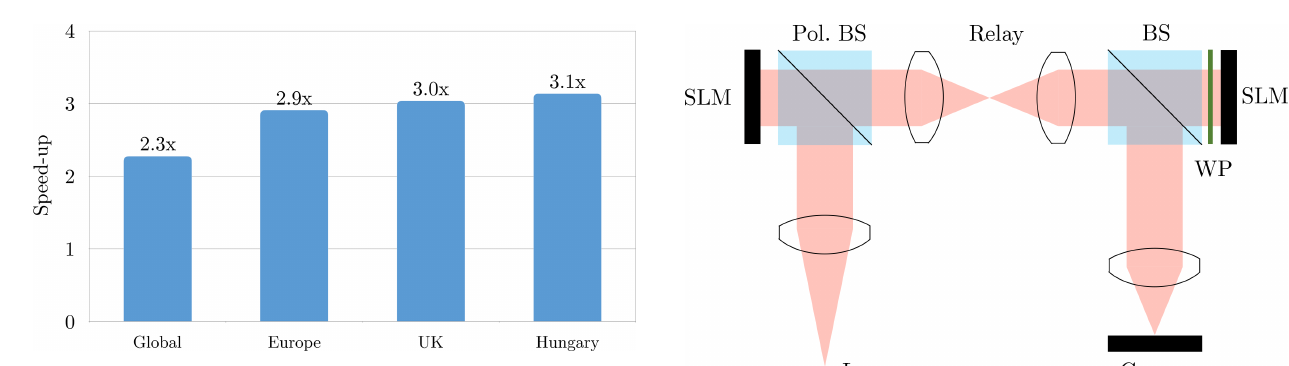
Figure 10. Speed-up of the spectral transform by porting optimisa- tions introduced in the GPU version back to the CPUs. The base- line for this comparison is the current operational post-processing library used at ECMWF. This version of the spectral transform al- lows for the computation on limited area domains. The speed-up is given here for the global transform and three examples of limited domains (Europe, UK, and Hungary).